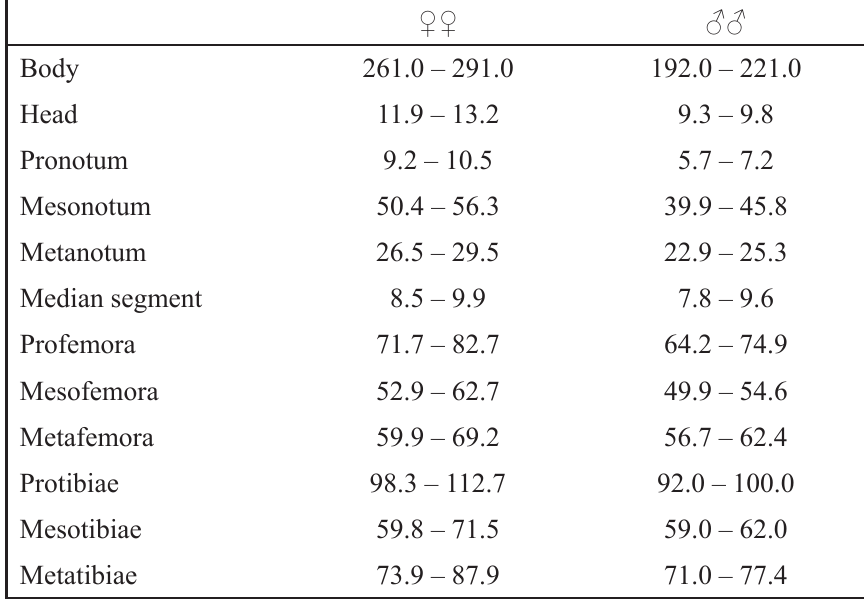
Table 1. Measurements (mm) of Phryganistria bachmaensis (Ta & Hoang,